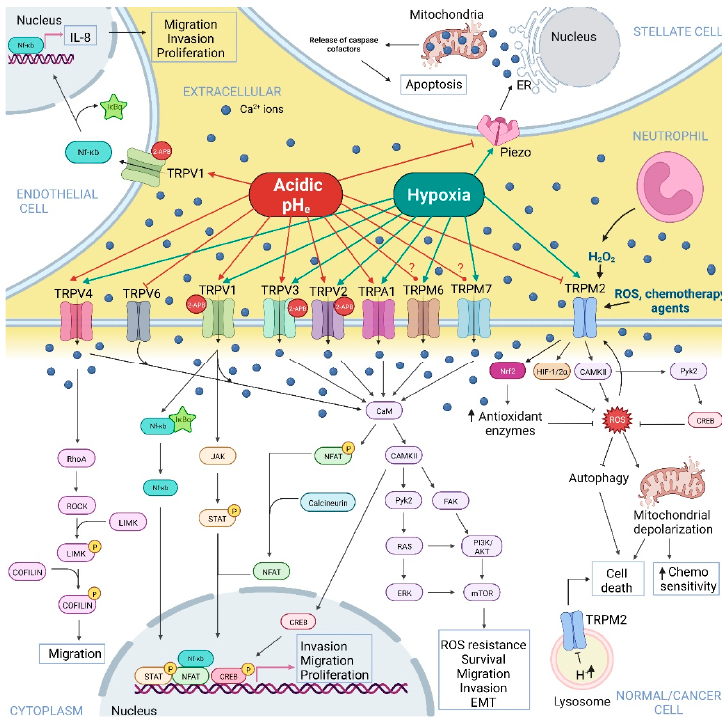
Figure 1. Overview of the effects of acidic pH e and hypoxia on TRP and Piezo Ca 2+ -permeable channels. The positive or negative effects of hypoxia and acidic pH e on the Ca 2+ -permeable channels were obtained from both normal and cancer cells-related studies, while the signalling pathways indicated were obtained uniquely from cancer cells-based investigations. The figure depicts Piezo-, TRPV-, TRPA1- and TRPM-mediated Ca 2+ -dependent signalling pathways activated or inhibited by acidic pH e and hypoxia and linked to tumour progression. TRPV (TRPV1–4, 6), TRPA1, and TRPM (TRPM6, 7) expressed in cell cancer’s plasma membrane are differentially regulated by acidic pH e , being mostly activated by tumour acidosis, and transducing its signals to activate Ca 2+ -dependent downstream effectors, such as NF- κ B, JAK/STAT, PI3K/AKT, NFAT, ERK, and LIMK. TRPA1 is also activated by hypoxia. These effectors promote tumour cell migration, invasion, proliferation, survival, mesenchymal phenotype, and chemoresistance. TRPV6 channels’ activity is inhibited by tumour acidosis, as TRPM2, which inhibition avoids induction of cancer cell death and reduces chemosensitivity. Piezo channels embedded in stellate cells’ plasma membrane are inhibited by acidic pH e , promoting stellate cells’ survival. TRPV1 activation in lymphatic endothelial cells promotes activation of NF- κ B and upregulation of IL-8, a lymphangiogenic factor. CaM, calmodulin; CAMKII, Ca 2+ /calmodulin-dependent protein kinase II; Pyk2, protein tyrosine kinase 2; RAS, Rat sarcoma virus; ERK, extracellular signal-regulated kinase; FAK, Focal Adhesion Kinase; PI3K, phosphoinositide 3-kinase; AKT, protein kinase B; mTOR, mammalian target of rapamycin; NF- κ B, nuclear factor- κ B; JAK, Janus kinases; STAT, signal transducer and activator of transcription; NFAT, nuclear factor of activated T-cells; RhoA, Ras homolog family member A; ROCK, Rho- associated protein kinase; LIMK, LIM domain kinase; CREB, C-AMP response element-binding protein. The question mark indicates contradictory results in the literature. Created with BioRender.com, accessed on 20 June 2022.